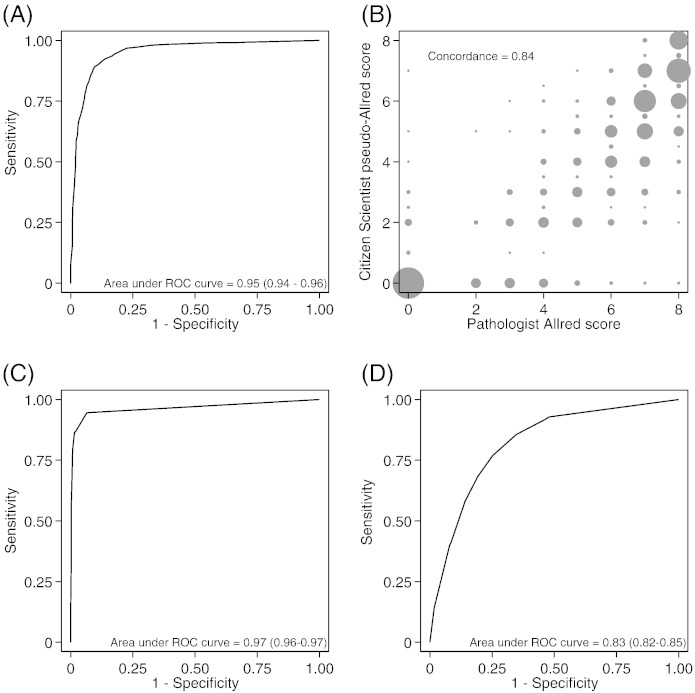
Accuracy of Citizen Scientist classifications. (A) Receiver operator characteristic curve for identification of cancer cells by Citizen Scientists in 3038 tumors from the SEARCH study compared to classification by a pathologist. (B) Frequency weighted scatterplot of Citizen Scientist pseudo-Allred score against the pathologist assigned Allred score for 2121 tumors from the SEARCH study. (C) Receiver operator characteristic curve for classification of ER status based on Citizen Scientist pseudo-Allred score against the pathologist classification for 2121 tumors from the SEARCH study; (D) receiver operator characteristic curve for classification of ER status based on Citizen Scientist pseudo-Allred score against the ER status recorded in the Breast Cancer Association Consortium data base from a variety of sources for 10,679 tumors from ten studies.